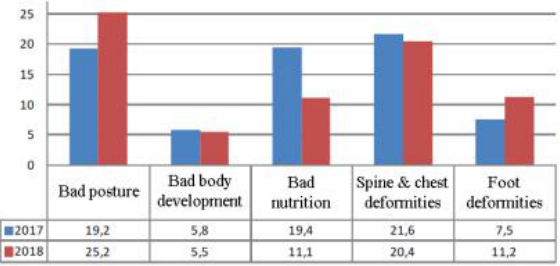
Figure 5. Most common pathological conditions identified in medical examinations of high school students (Source: Institute of Public Health in Skopje [14])